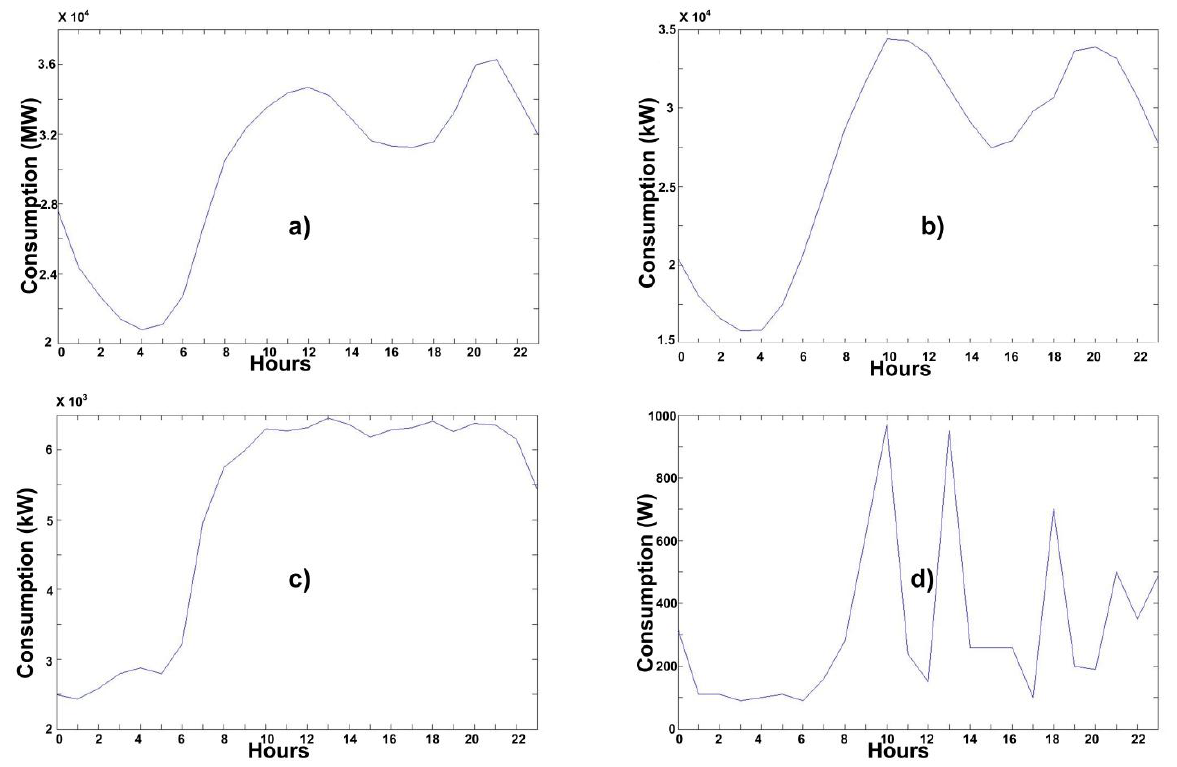
Figure 1. ( a ) Country; ( b ) substation (potential microgrid ); ( c ) industrial park (potential microgrid ); ( d ) home